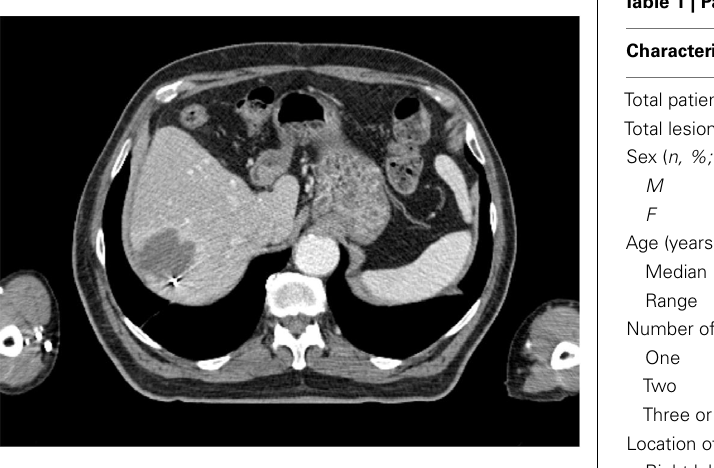
FIGURE 2 | Pre-treatment CT scan.